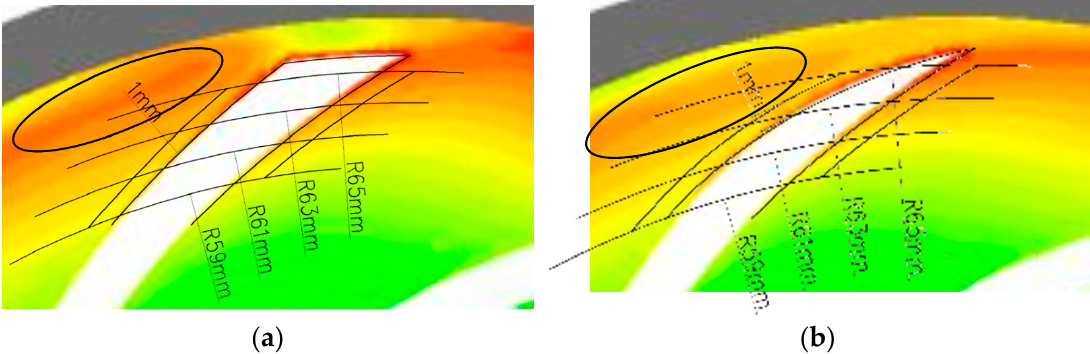
Figure 14. Arrangement order of local velocity monitor points near the blades (span = 0.5): ( a ) prototype; ( b ) Model C. Table 3. Averaged local velocities of monitor points.